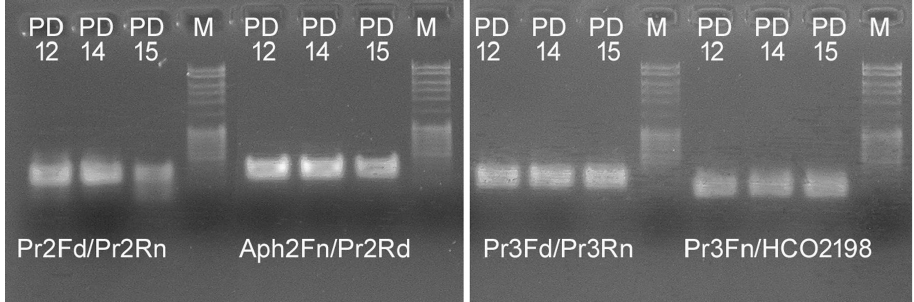
Figure 4. Agarose gel visualizing the products of nested trials with products of direct PCR for samples PD12 - P. barbatum , PD14 - P. yomenae , and PD15 - P. yomenae . The products from PCR with Pr2Fd/ Pr2Rd were submitted to secondary nested trials with primer pairs Pr2Fd/Pr2Rn and Aph2Fn/Pr2Rd. Amplicons obtained with Pr3Fd/HCO2198 were used as the template for nested reactions with Pr3Fd/ Pr3Rn and Pr3Fn/HCO2198.